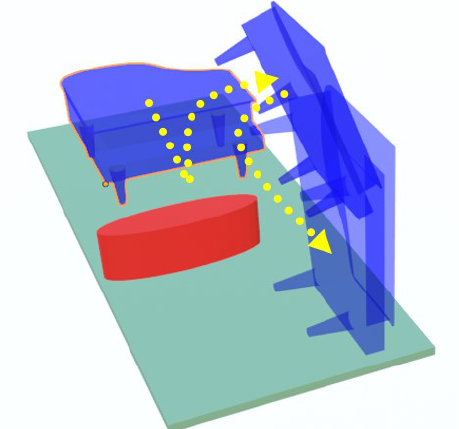
Figure 2. Manipulation of a piano by ( a ) pivoting, ( b ) tumbling, and ( c ) regrasping.